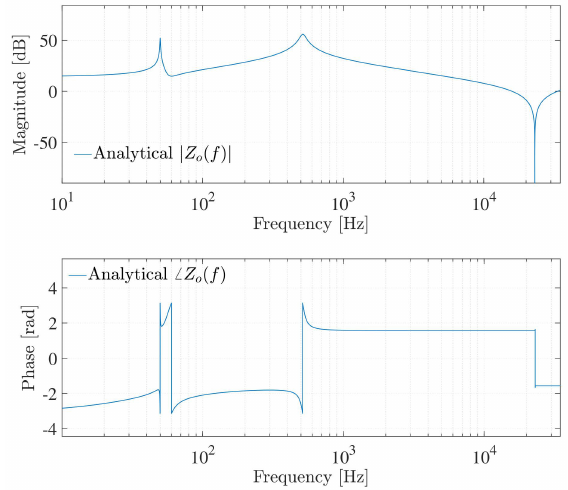
Figure 3. Magnitude and phase response of the analytical inverter output